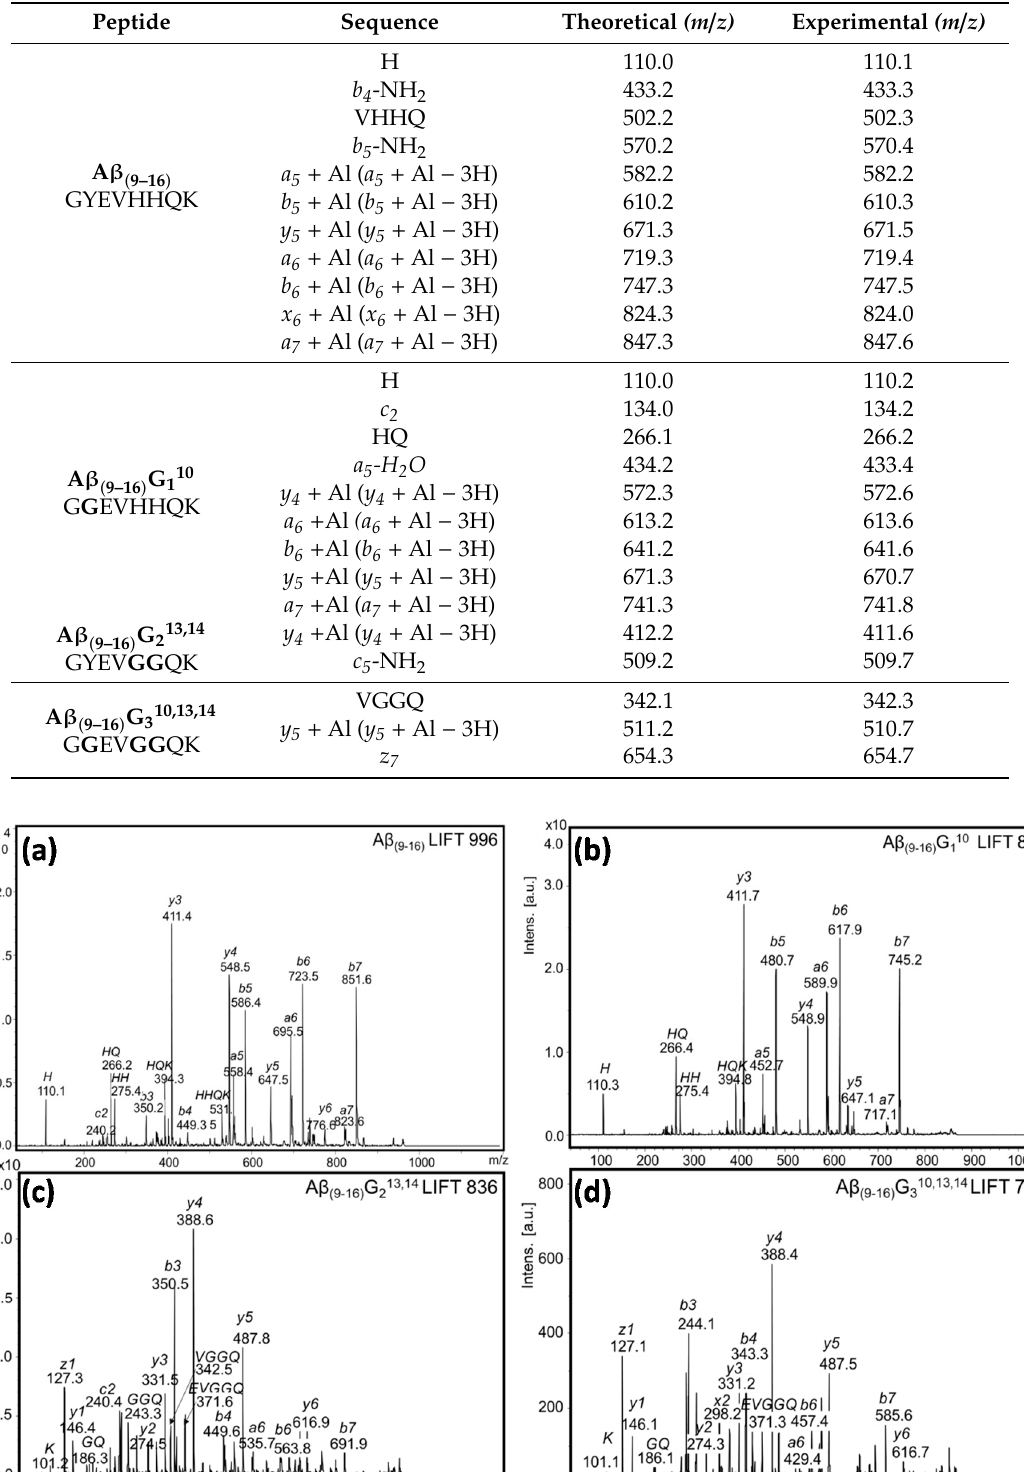
The m / z values calculated and measured experimentally using MS / MS spectra of ions [M + Al(III)-2H] + following the collision-induced dissociation (CID) fragmentation (MALDI mass spectrometer).